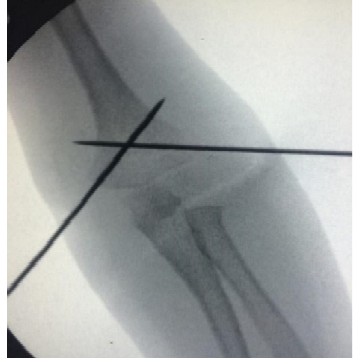
Figure 3. One lateral and one medial pin con fi guration for supracondylar humeral fracture.